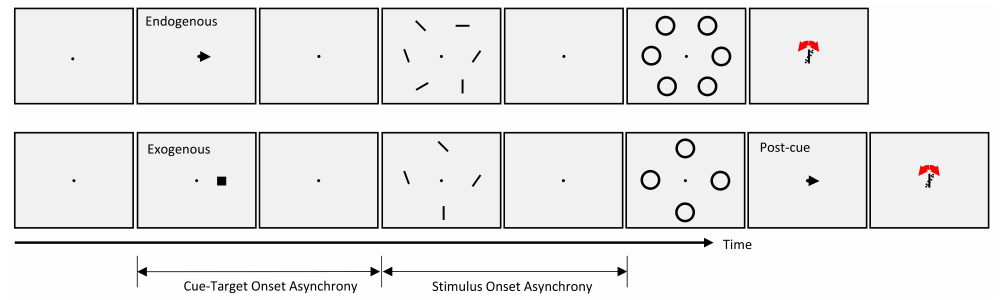
Figure 1. The stimulus sequences for both the endogenous ( top ) and exogenous ( bottom ) attention